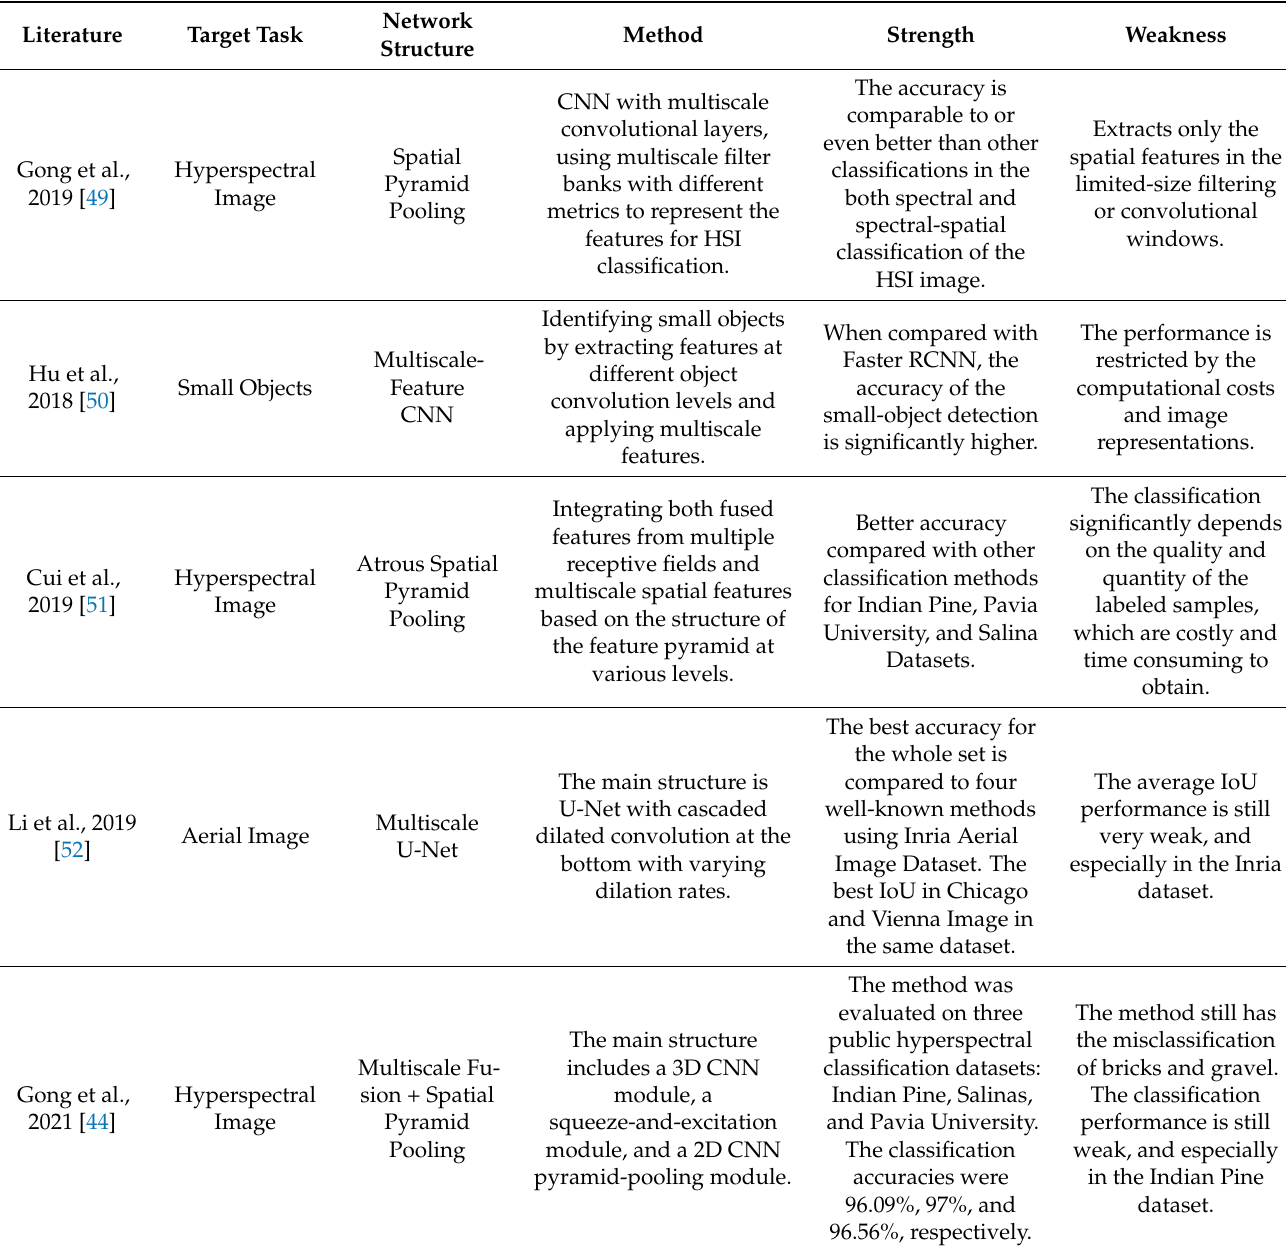
Table 1. The Application of Multiscale Deep Learning in Satellite